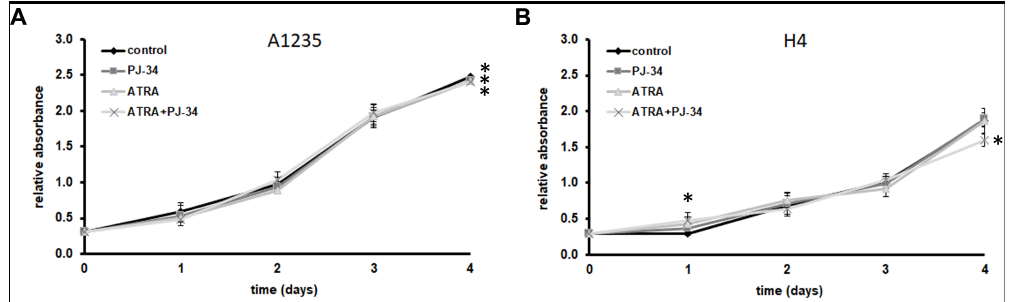
Figure 1. Growth curves of A1235 and H4 cells treated with all-trans retinoic acid (ATRA) and the poly(ADP-ribosyl) polymerase (PARP) inhibitor: Cells were treated every second day with 10 µ M ATRA and 20 µ M PJ-34 and their combination. Cell proliferation was determined by crystal violet staining and absorbance measurement. ( A ) A1235 cells; ( B ) H4 cells. * The mean values were significantly different from the control ( p < 0.05).